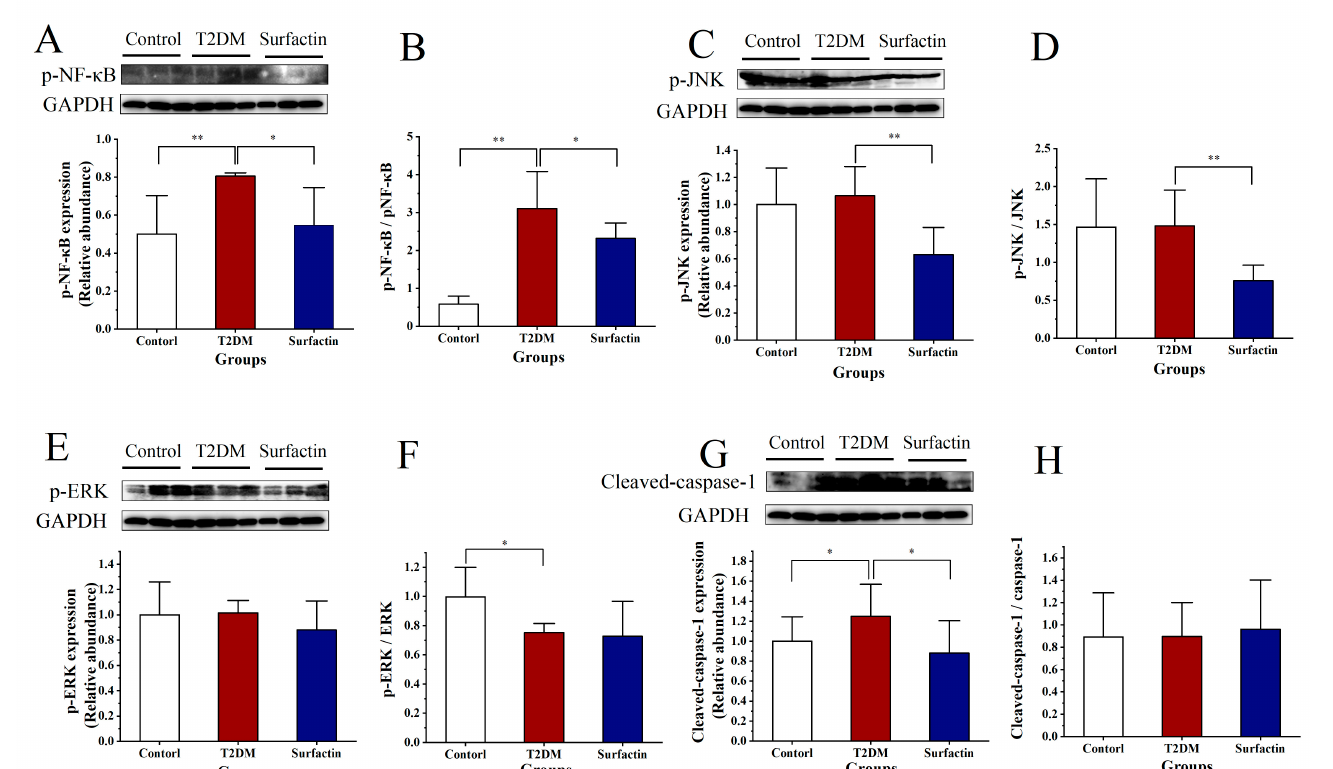
Figure 2. Effects of surfactin on pancreas inflammation in HFD/STZ-induced T2DM mice. The control group represents normal mice fed a basic diet, the T2DM group represents mice with T2DM induced by a 60% fat diet and 30 mg/kg body weight STZ, and the surfactant group represents T2DM mice treated with 80 mg/kg body weight surfactin. The levels of p-NF- κ B ( A ), p-NF- κ B/ NF- κ B ratio ( B ), p-JNK ( C ), p-JNK/JNK ratio ( D ), p-ERK ( E ), p-ERK/ERK ratio ( F ), Cleaved-Caspase-1 ( G ), and Cleaved-caspase-1/caspase-1 ratio ( H ). All data are presented as the means ± SD for each group. * indicates significant differences at p < 0.05, ** indicates significant differences at p < 0.01.